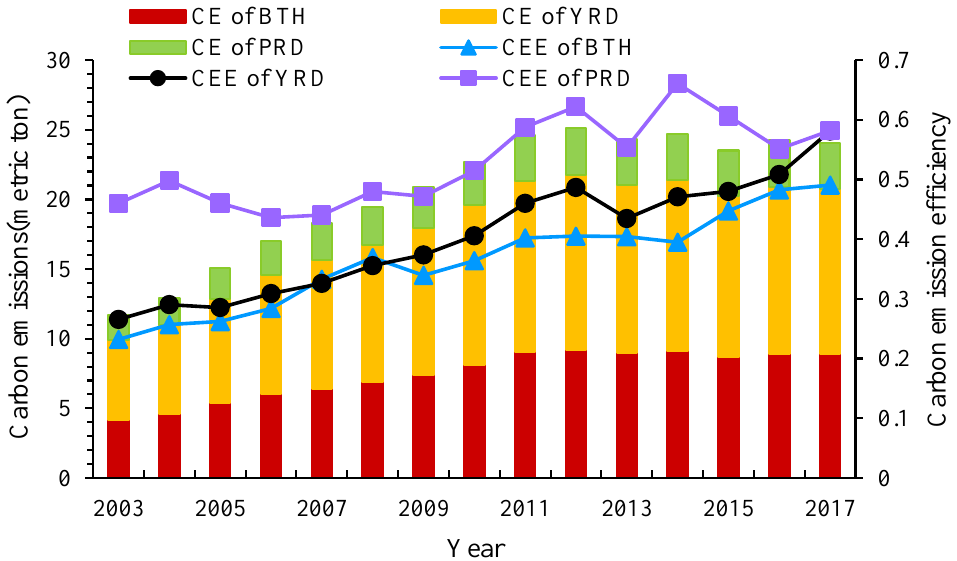
Figure 2. Evolution of China’s carbon emissions (CE) and CEE in the three major urban agglomera- tions from 2003 to 2017.